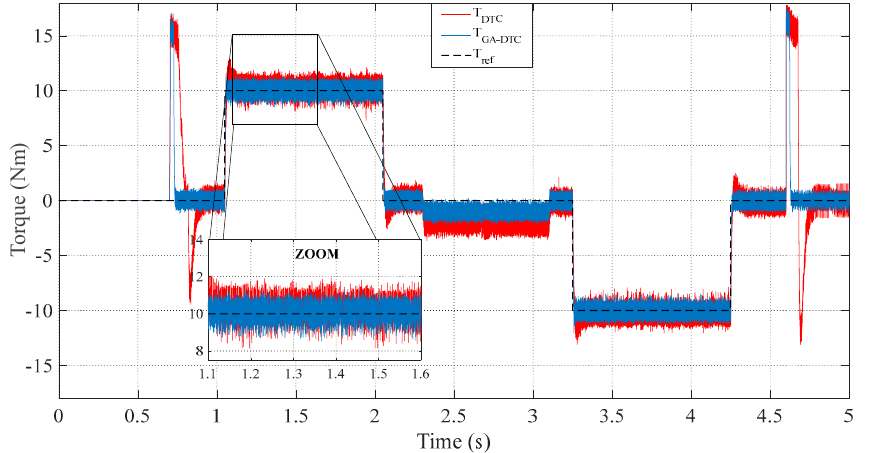
Figure 7. Torque dynamics of the DTC and GA–DTC.